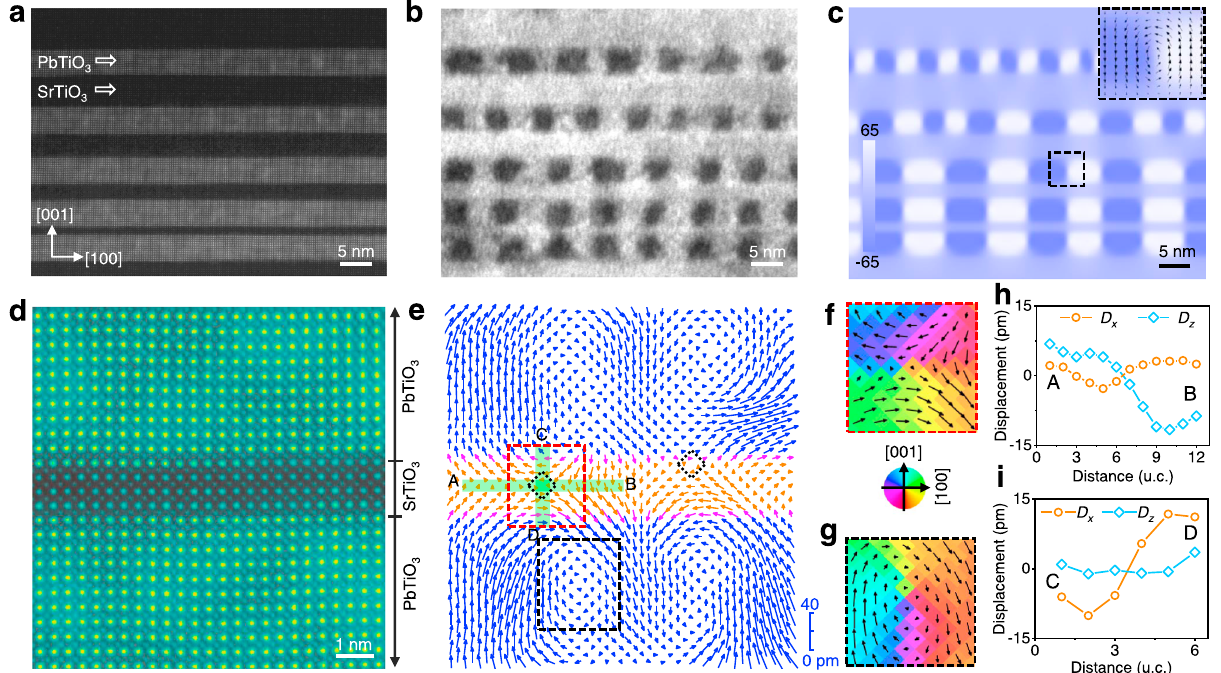
Fig. 2 Polar vortex – antivortex pairs in designed (PTO) n /(STO) m superlattice. a A low-magni fi cation HAADF image depicts STO layers with varying thicknesses (4, 7, 10, and 15 u.c.) sandwiched between 10-u.c. PTO layers. b Dark fi eld TEM image under two-beam conditions by selecting (002) pc g vector (subscript pc denotes pseudocubic). The periodic array of bright and dark intensity modulation corresponds to vortex arrays within PTO layers. c The spatial distribution of the out-of-plane polarization (unit: μ C/cm 2 ) was calculated from phase- fi eld simulation. Inset: enlarged view of the polar vector con fi guration (black arrows). d An atomically resolved HAADF image for a 4-u.c. thick STO sandwiched between adjacent 10-u.c. PTO layers, colored for clarity. e Map of polar vectors between cations extracted from the HAADF image depicts vortex – antivortex texture. The cores of antivortices are highlighted by the dotted diamond boxes. Enlarged views of polar vectors overlaid with polar angle variation taken from dashed highlighted rectangle boxes in e for antivortex (red color) in STO ( f ) and vortex (black color) in PTO ( g ), respectively. Variation of polar displacement components within antivortex structure along A – B ( h ) and C – D ( i ) directions, as marked in e . D x represents in-plane displacement and D z represents out-of-plane